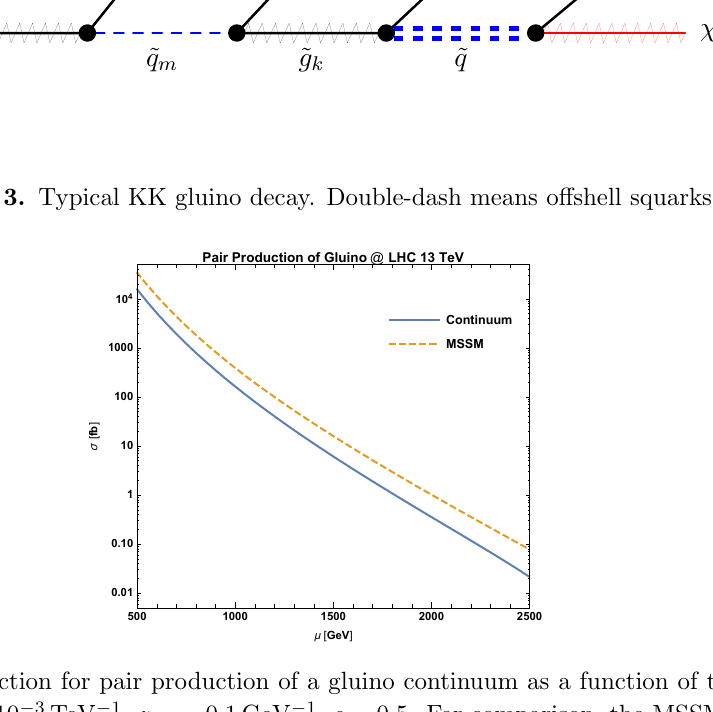
Figure 4. Cross section for pair production of a gluino continuum as a function of the threshold (cid:22) , assuming z UV = 10 (cid:0) 3 TeV (cid:0) 1 , z IR = 0 : 1 GeV (cid:0) 1 , c = 0 : 5. For comparison, the MSSM gluino pair production cross section (with gluino mass (cid:22) ) is also